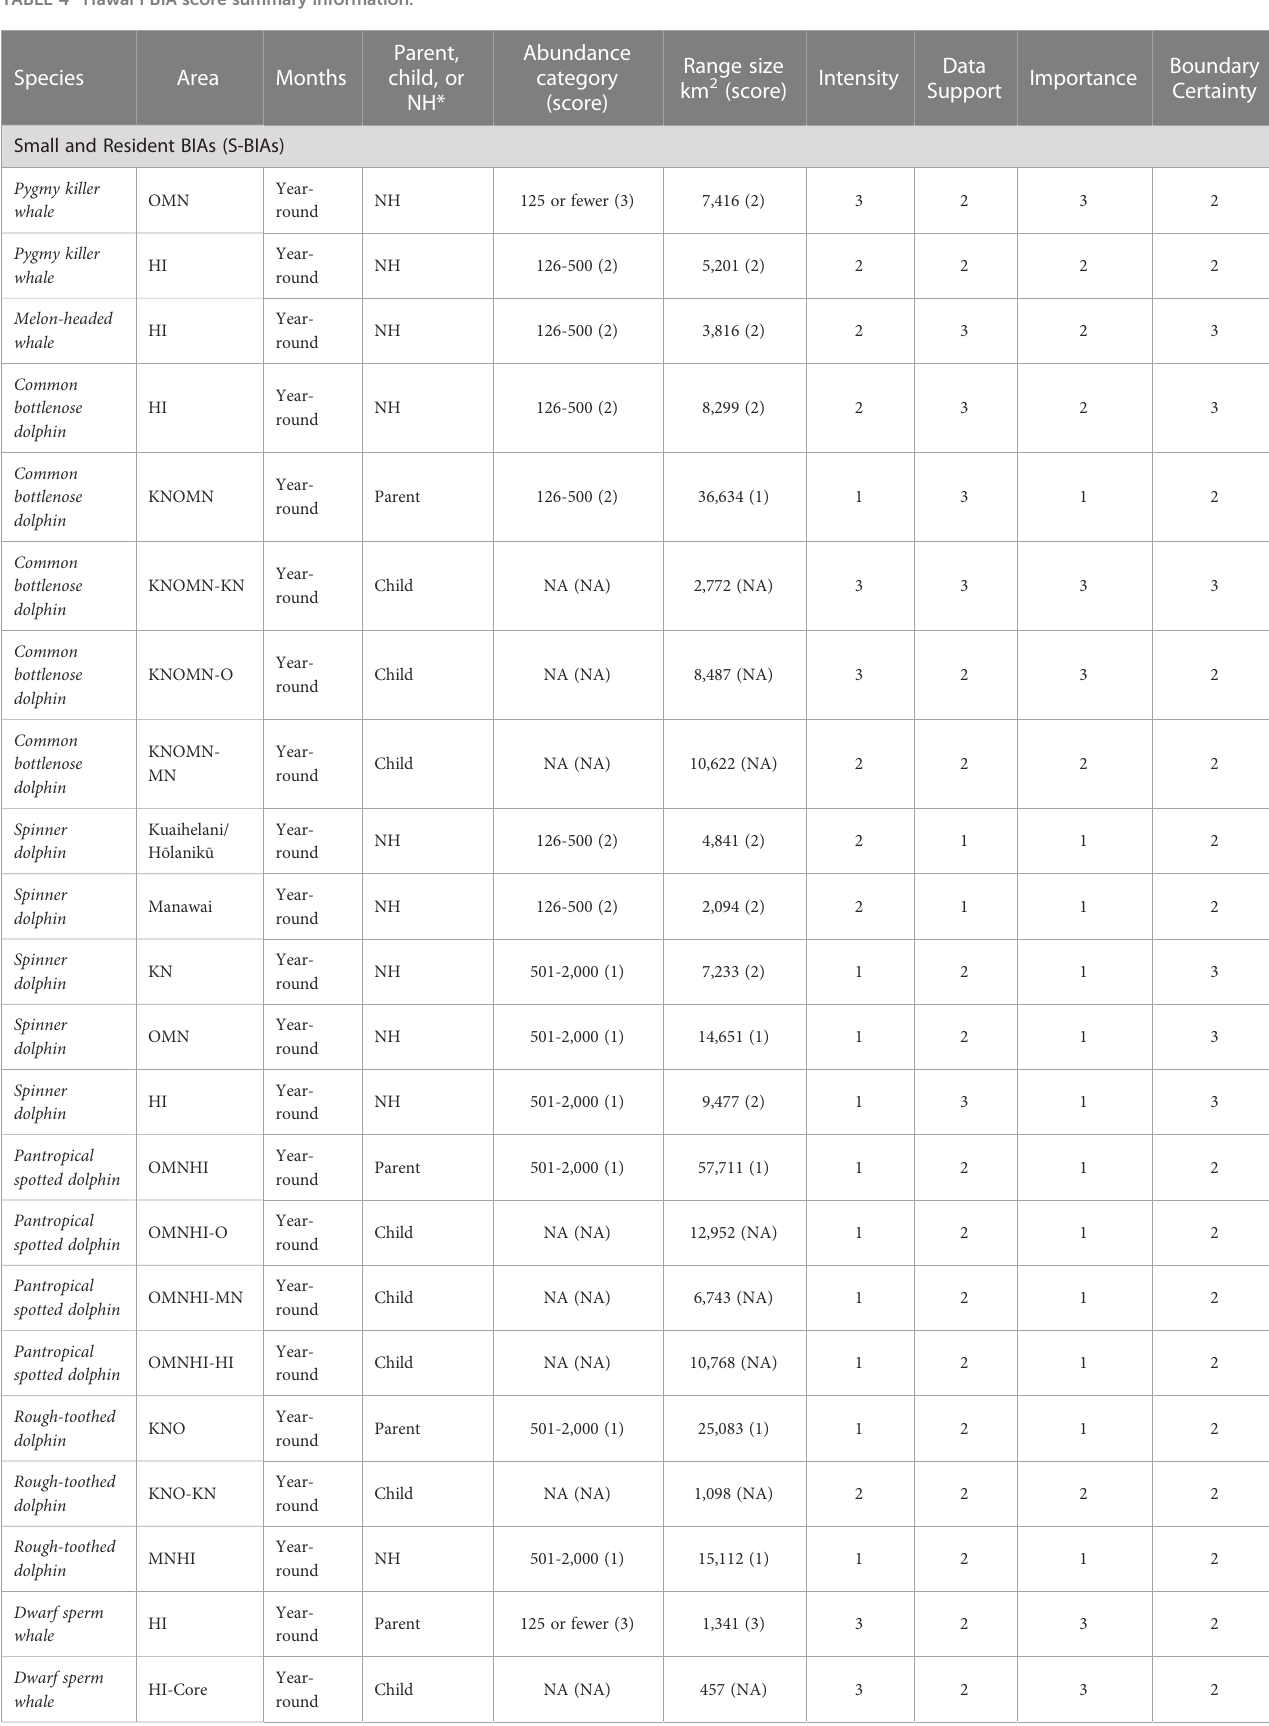
TABLE 4 Hawai ʻ i BIA score summary information.